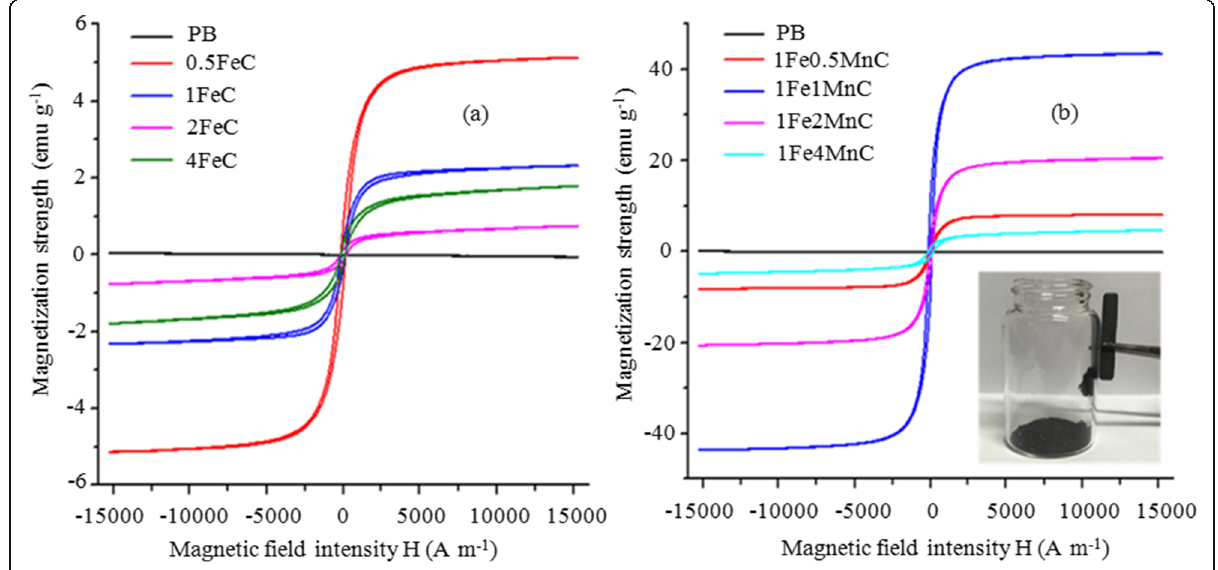
Fig. 3 Hysteresis regression analysis of a x FeC and b x Fe y